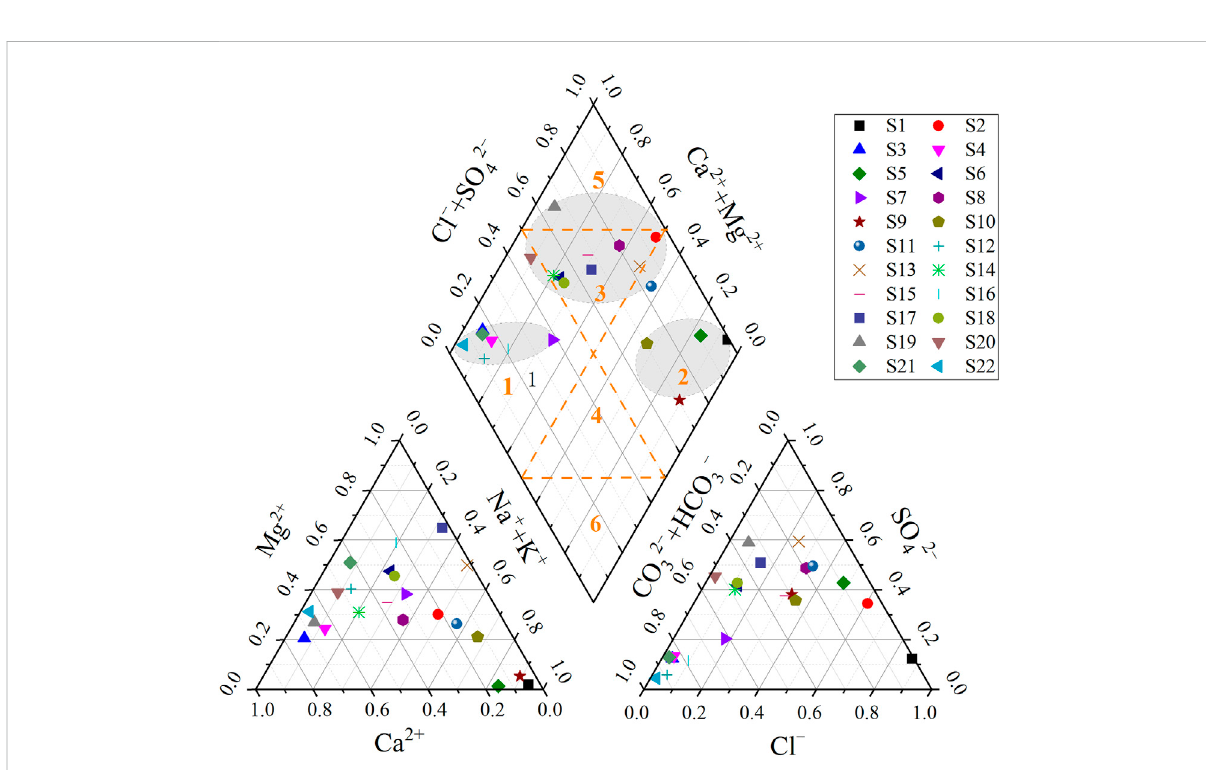
FIGURE 4 Piper trilinear nomograph for the water